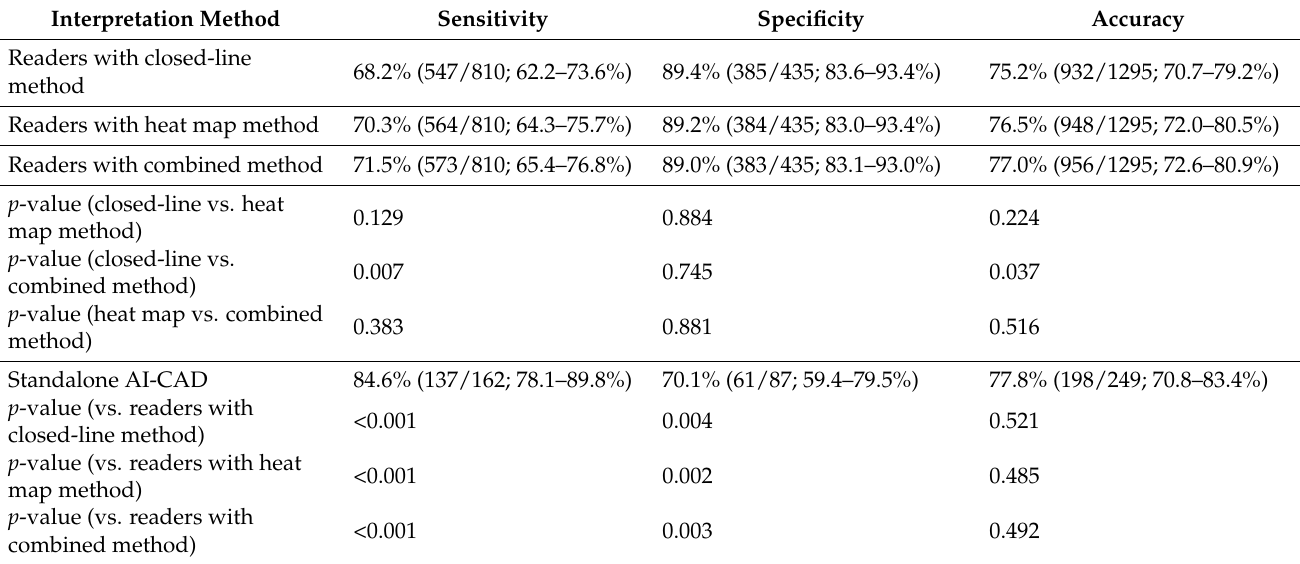
Table 3. Sensitivity, specificity, and accuracy of interpretation by readers and stand-alone